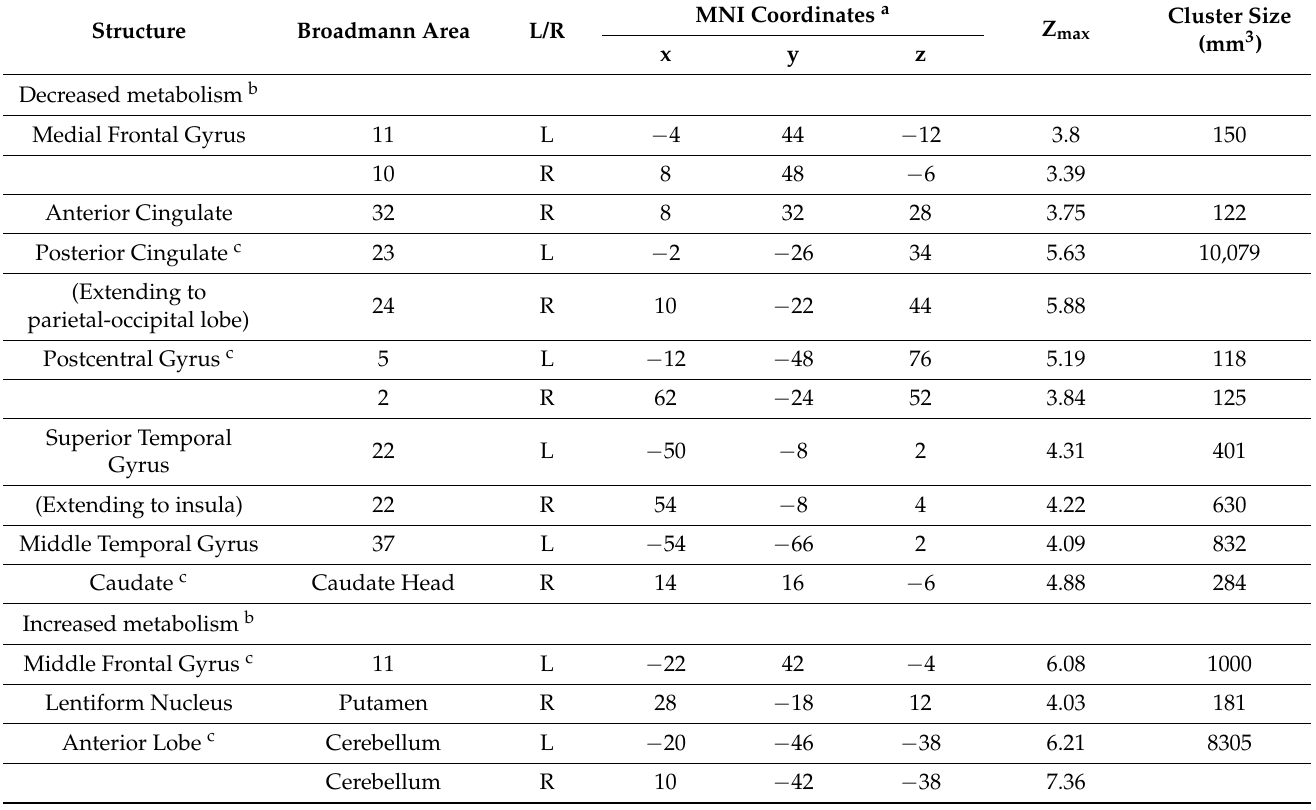
Table 3. Brain regions with significant metabolic differences in HIE patients compared with HC